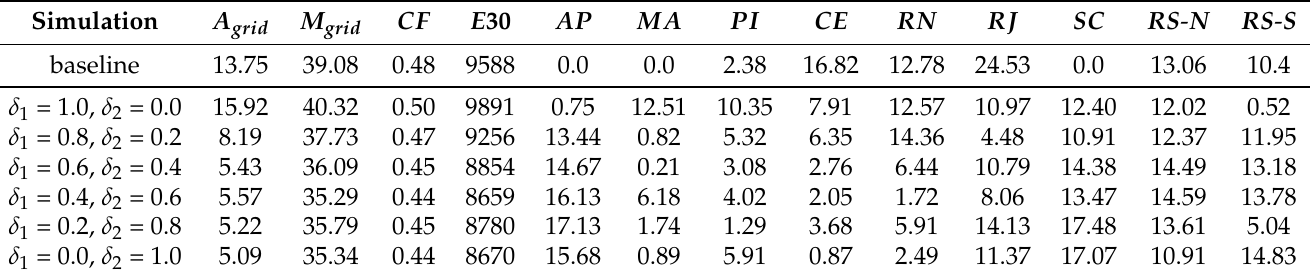
Table 3. Results for offshore grid simulation and optimization. Baseline refers to the distribution of wind farms currently under environmental licensing at IBAMA. The other cases refer to the results of grid optimization. Here, δ 1 weights are used for total power generation, while δ 2 minimizes the seasonal amplitude of P grid . For each Pareto pair, the GA finds the optimized α i distribution of wind turbines for each farm cluster. A grid is the seasonal amplitude, M grid is the average production of the power grid ( P grid ) in GW units, CF refers to the mean capacity factor of the grid, and E 30 refers to the generated energy in TWh integrated from P grid for a 30-year simulation period. The installed capacity of each cluster ( AP to RS - S ) is presented in GW units.